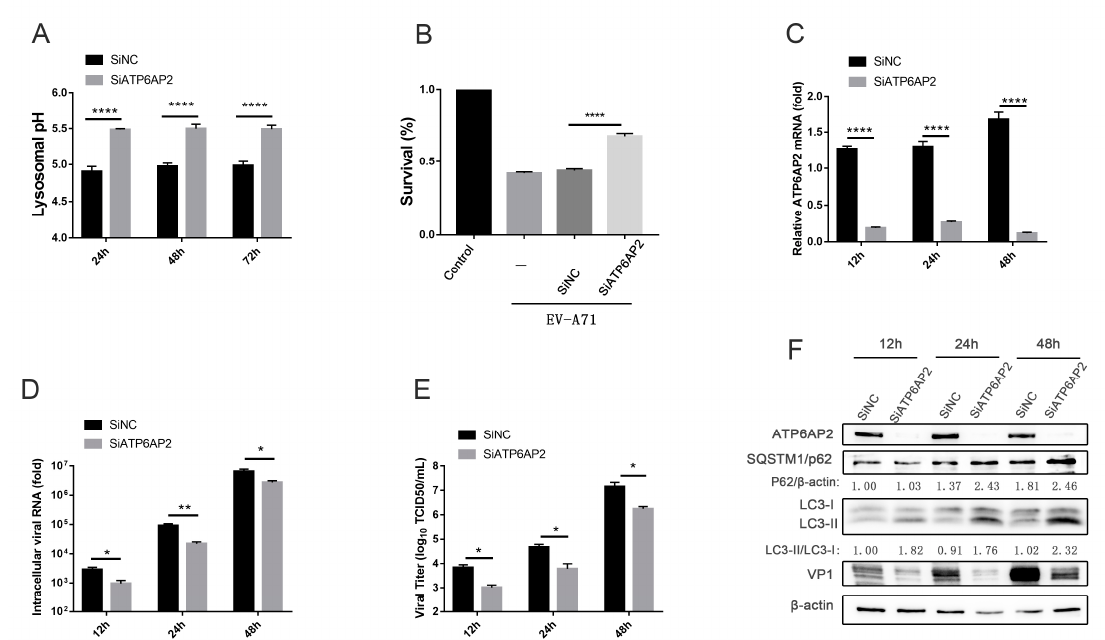
Figure 4. Knockdown of ATP6AP2 (V-ATPase) suppresses EV-A71 infection. ( A ) RD cells were transfected with SiNC or SiATP6AP2, and the lysosomal pH was measured using fluorescent probes at di ff erent time points. ( B ) RD cells were transfected with SiNC or SiATP6AP2 for 24 h and then infected with EV-A71 (MOI = 5) for 24 h. A CCK-8 assay was performed to determine the cell survival rate. ( C – F ) RD cells were transfected with SiNC or SiATP6AP2 for 24 h and then infected with EV-A71 (MOI = 1). At di ff erent time points after infection, ATP6AP2 mRNA ( C ) and intracellular viral RNA ( D ) levels were measured via RT-qPCR, ( E ) viral titers in the supernatants of infected cells were determined by TCID50 assays, and ( F ) proteins were detected by Western blot analysis. * p < 0.05, ** p < 0.01, and **** p < 0.0001.